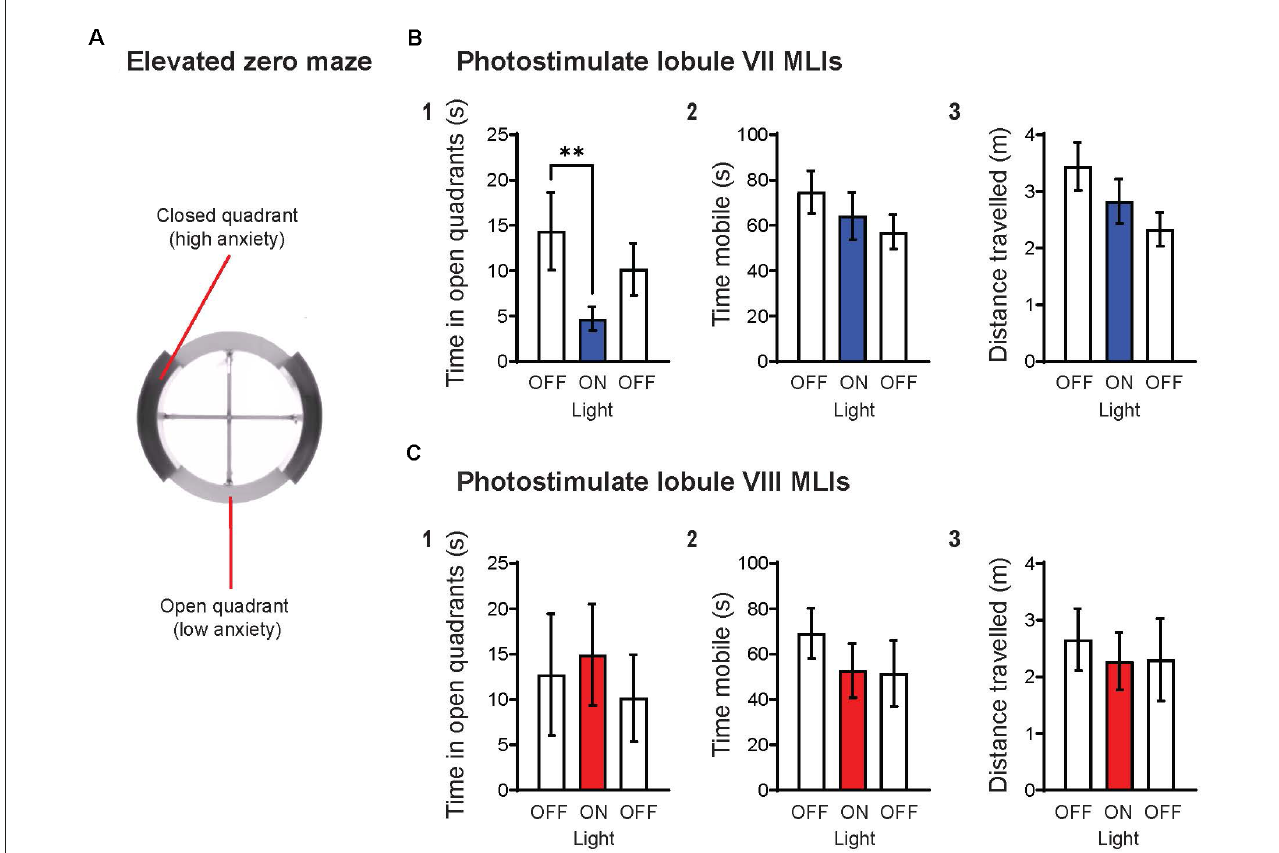
FIGURE2 Optogenetic stimulation of MLIs in lobule VII, but not lobule VIII, increases anxiety levels. (A) Schematic representation of the elevated zero maze (EZM), consisting of two open quadrants (45 lux) and two closed quadrants (15 lux) enclosed by 14 cm high walls. The EZM has an outer diameter of 55 cm, a 6 cm-wide platform, and is elevated 60 cm off the floor. Animals were tested on the EZM for a total of 6 min, with three 2-min epochs OFF-ON-OFF, where light (470 nm, 11 mW/mm 2 , 10 Hz, 50% duty cycle) was delivered only during the “ON” epoch. Timed light delivery and behavioral tracking were performed using the ANY-maze software. Upon completion of experiments, histological confirmation of genotype and optical fiber placement were performed for all animals. Animals with indeterminate or incorrect placement of optical fiber were excluded from the analysis. (B) Photostimulation of lobule VII MLIs (1) significantly decreased time spent in open quadrants ( p = 0.008**), yet had no effect on (2) mobility or (3) distance traveled. (C) Photostimulation of lobule VIII MLIs did not have any significant effects on the indicated behaviors. Wilcoxon signed rank test; lobule VII: n = 8; lobule VIII, n = 5. Data are mean ±